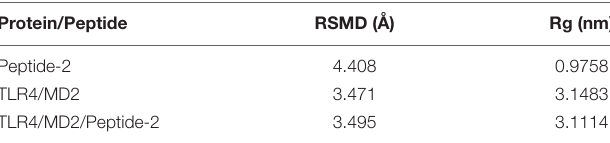
TABLE 3 | Mean values of RMSD and Rg calculated for different molecular structures simulated by molecular dynamics of the TLR4/MD2/Peptide-2 complex at 310 K for 100 ns.